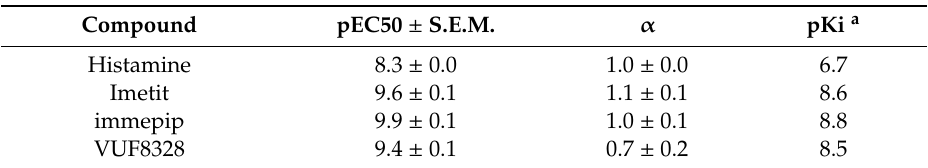
Table 1. Potencies, intrinsic activities ( α ) of ligands in hH 3 R-mediated G α i2 activation in HEK293T cells measured as recruitment of Venus-G β 1 γ 2 to masGRK3ct-Nluc. Data shown are mean ± S.E.M. of three experiments performed in triplicate.